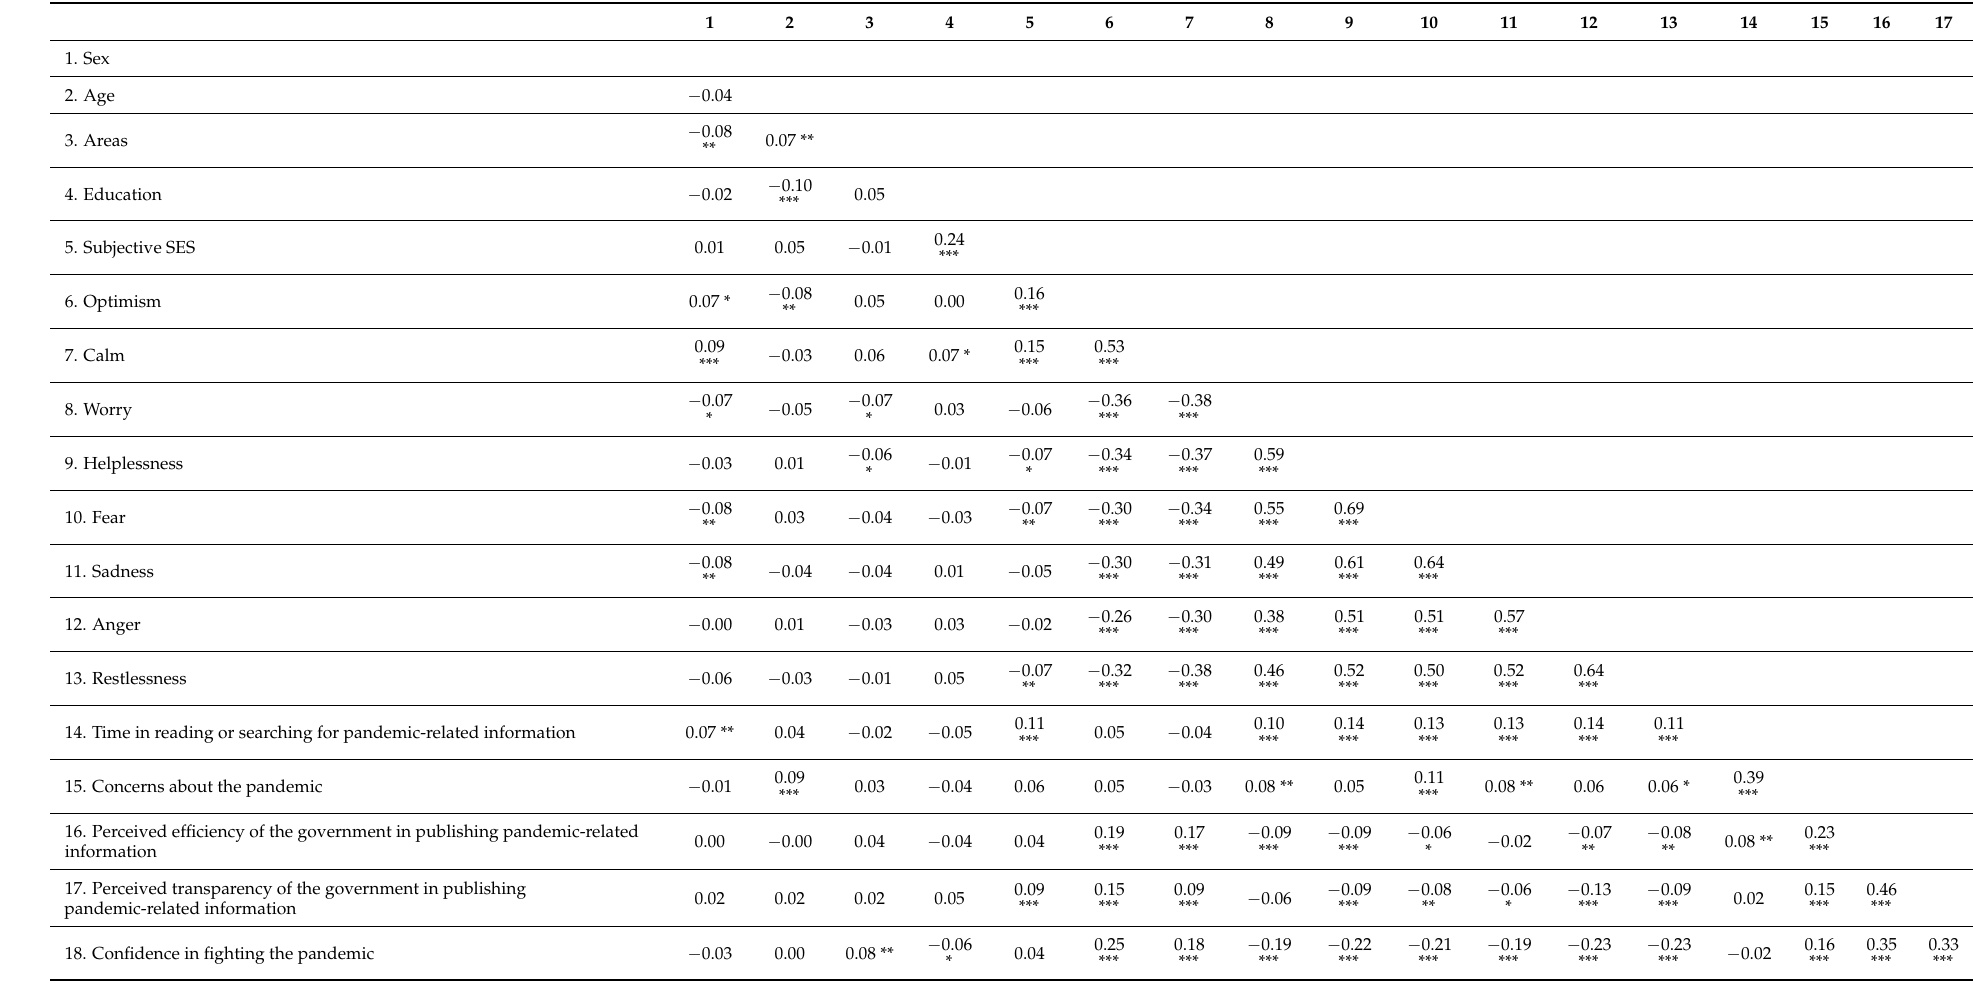
Table 3. Correlation between demographic variables, social emotions, concerns about the pandemic, perceived efficiency, transparency of the government, and confidence in fighting the